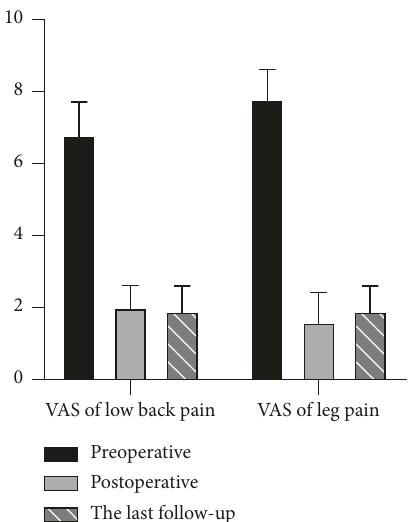
Figure 5: The comparison of the visual analogue scale. Compared with preoperative, the postoperative VAS significantly decreased with no significant increase in the VAS in the last follow-up.